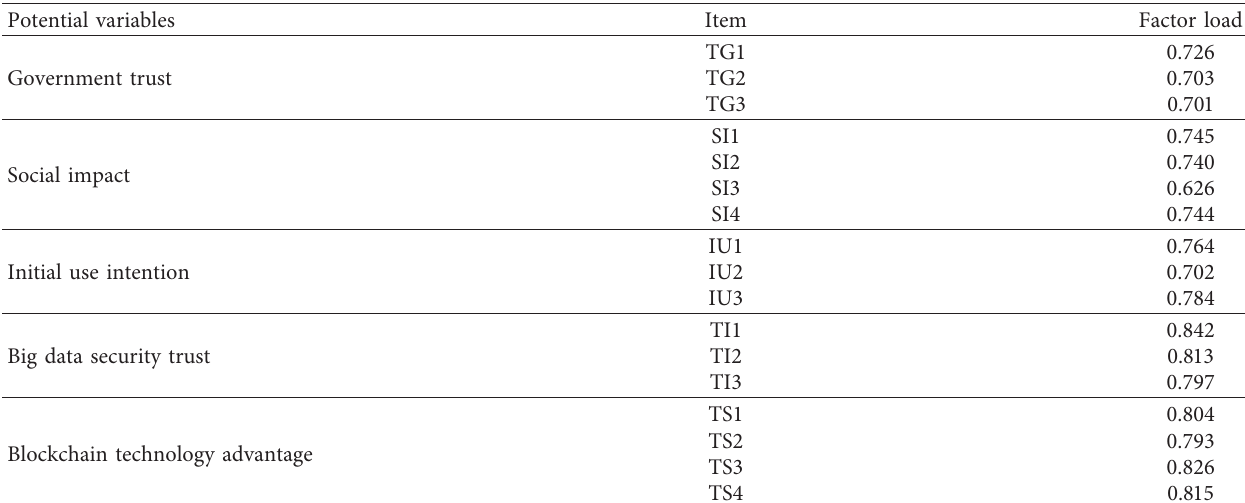
Table 4: Principal component factor load at the initial acceptance